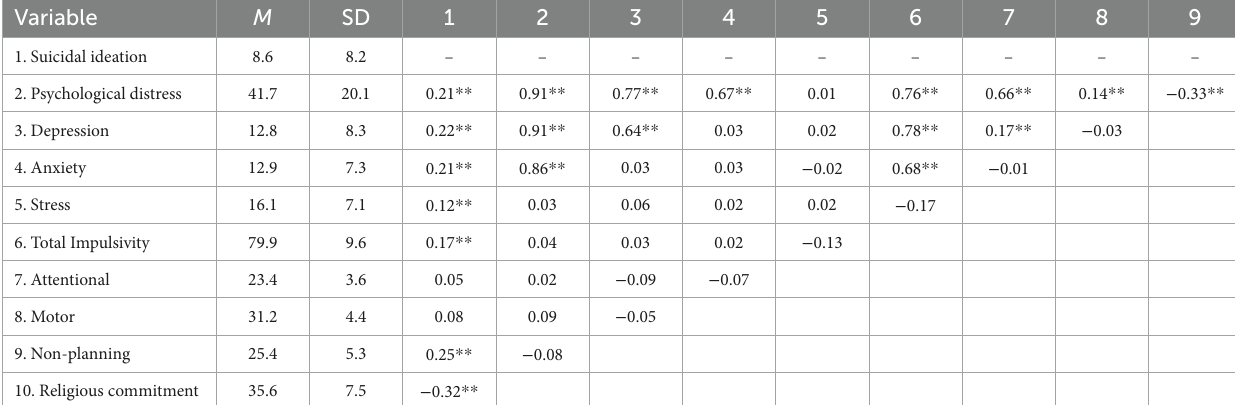
TABLE 2 Correlation